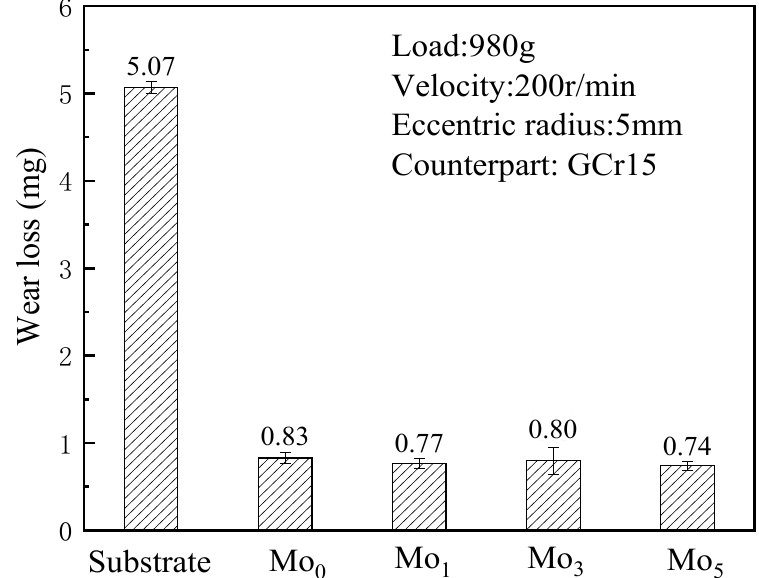
Figure 11. Wear loss of substrate and the laser cladding coatings.